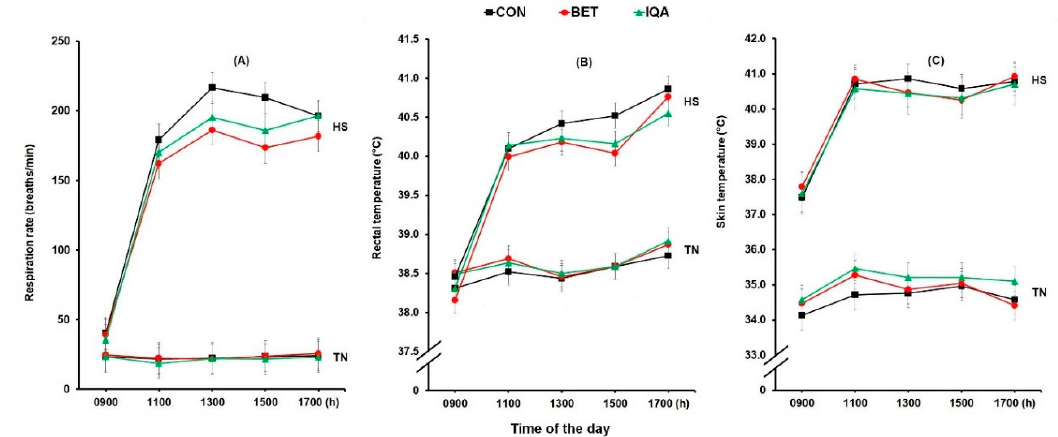
Figure 1. Changes in daily respiration rate ( A ), rectal temperature ( B ), and skin temperature ( C ) of grower pigs fed a control diet (CON), betaine (BET), or isoquinoline alkaloids (IQA) diets under thermoneutral (TN) or heat stress conditions (HS). Each figure represents the adjusted means ± pooled SED of two days of observations for the interaction between T × D × time. Panel ( A ) the respiration rate was significantly increased by HS ( p < 0.001), time of the day ( p < 0.001) and was lower with BET and IQA than CON overall (diet p = 0.024) and during HS (diet*temp. p = 0.013). ( B ) Rectal temperature was significant increased by HS ( p < 0.001), time of the day ( p < 0.001) and was lower with BET and IQA than CON during HS (diet p = 0.001) while no main effect of diet was observed. ( C ) Skin temperature was increased by HS ( p < 0.001), time of the day ( p < 0.001) and was lower with IQA than CON during HS (diet p = 0.046) while no main effect of diet was observed. There were interactions between temp × time ( p < 0.001) on respiration rate, rectal temperature and skin temperature whereas no temp × diet × time was observed and each group represents n = 8–9 pigs.